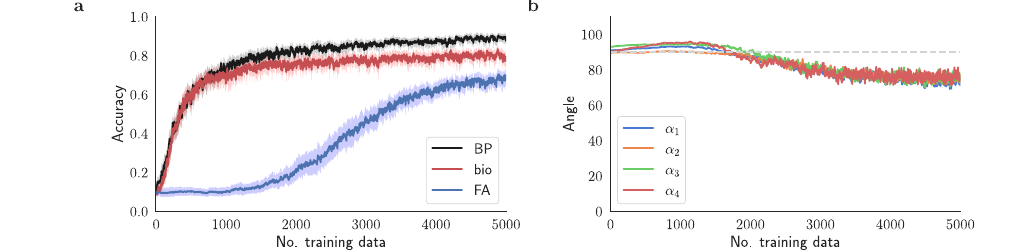
Fig. 1 | Feedback alignment learns poorly in deep models. Performance of benchmark learning schemes while training a 5-layer fully connected classi fi er network on MNIST digits 47 with online learning. a Accuracy versus the number of trainingdataforFeedbackAlignment(FA) 5 andbackprop(BP) 1 methods,compared tothediscoveredbiologicallyplausibleplasticityrule(bio)presentedbelow. b The angle α ℓ between the teaching signal e FA ‘ transmitted by the Feedback Alignment